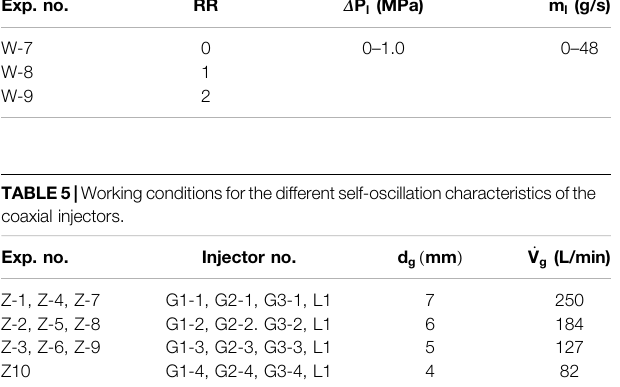
TABLE 4 | Working conditions ofthe liquid injectors to study recess ratio impacts. Exp. no.